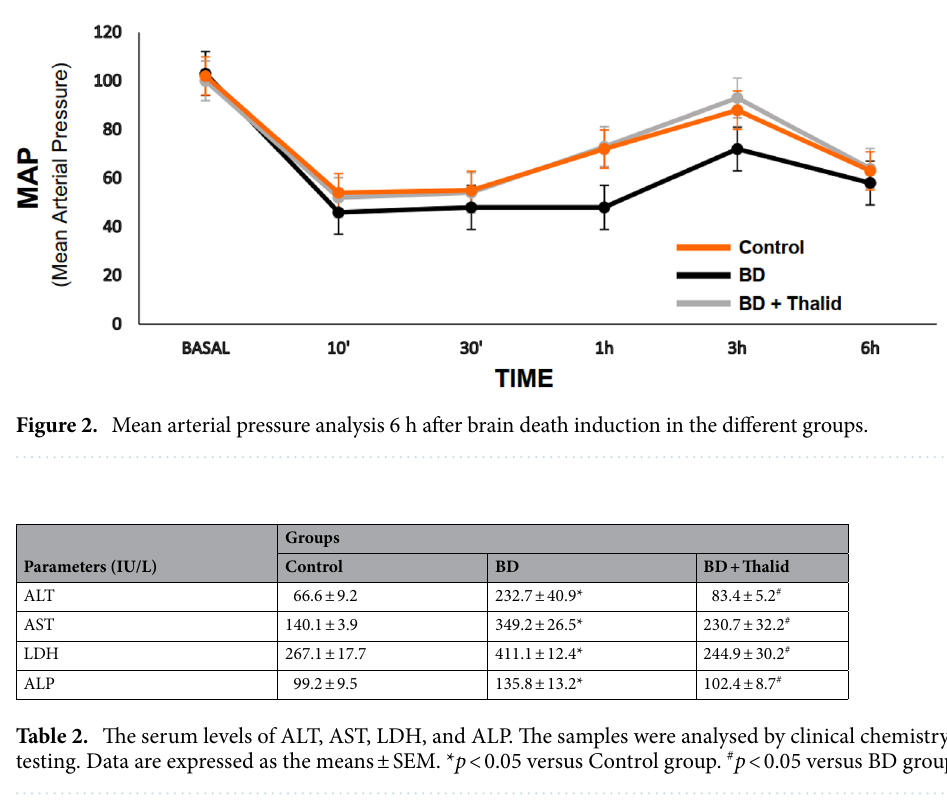
Effects of thalidomide on hepatic injury markers. Assessing hepatic injury, the serum levels of ALT, AST, LDH, and ALP were significantly higher in the BD group than the control group. These enzymes were reduced by thalidomide treatment (Table 2). Thalidomide diminishes macrophage infiltration in liver tissue. The anti-inflammatory effects of thalidomide on liver tissue were demonstrated by immunohistochemistry staining. In the BD group, the immu- nohistochemical assays demonstrated significant M1 macrophage infiltration compared with the control group